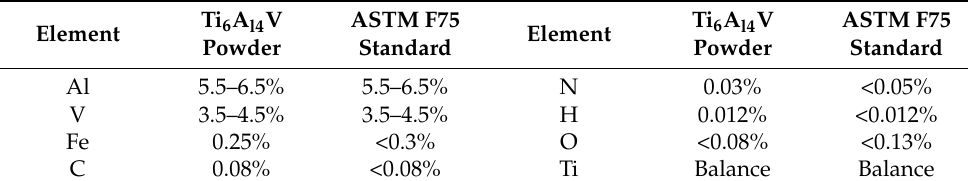
Table 1. The comparison of powder materials manufactured by SLM and ASTM F136 standards.